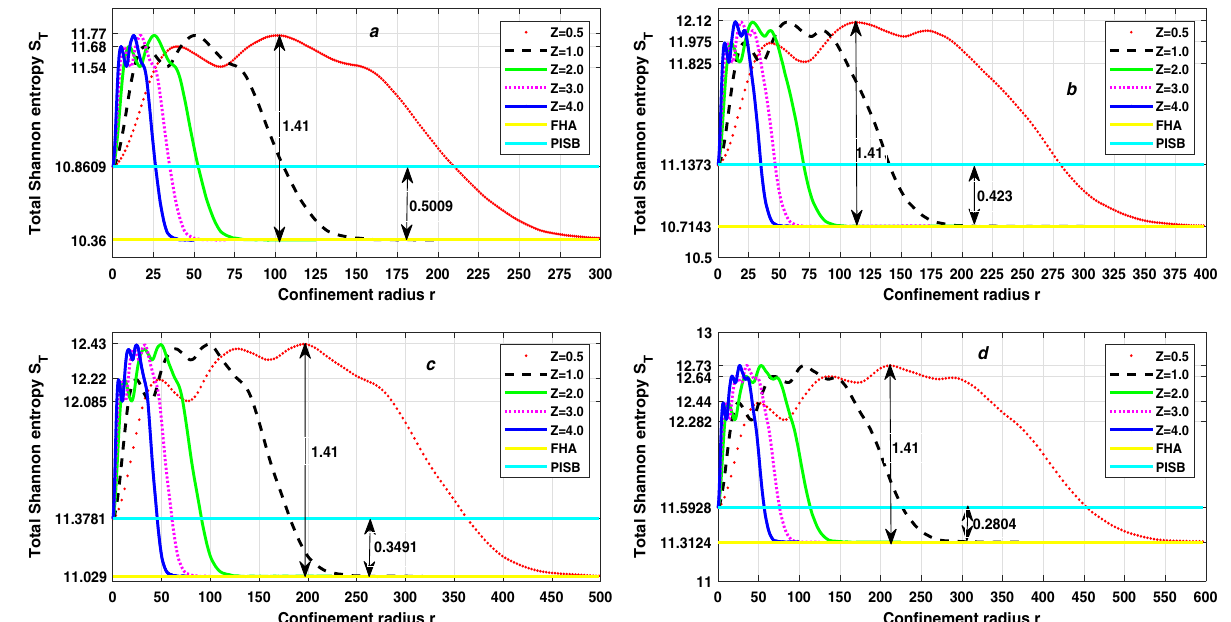
Figure 4. The variation of Total Shannon entropy S T with confinement radius r and atomic number Z for 7s state ( a ), 8s state ( b ), 9s state ( c ) and 10s state ( d ) of trapped Hydrogen-like